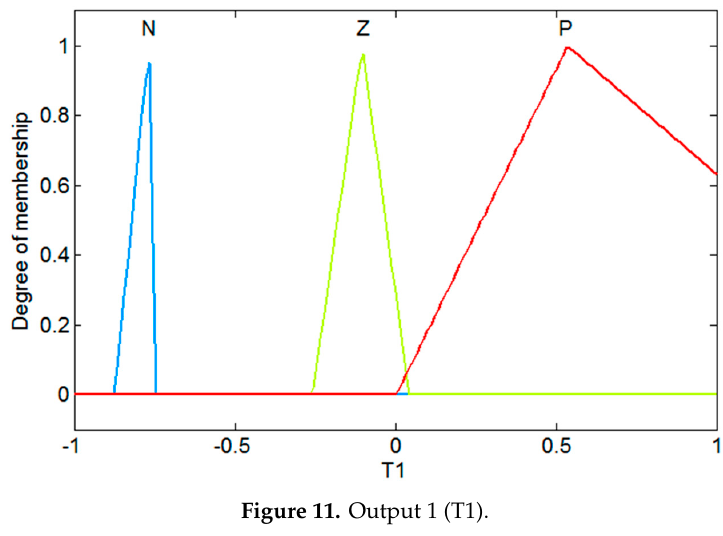
Figure 11. Output 1 (T1).